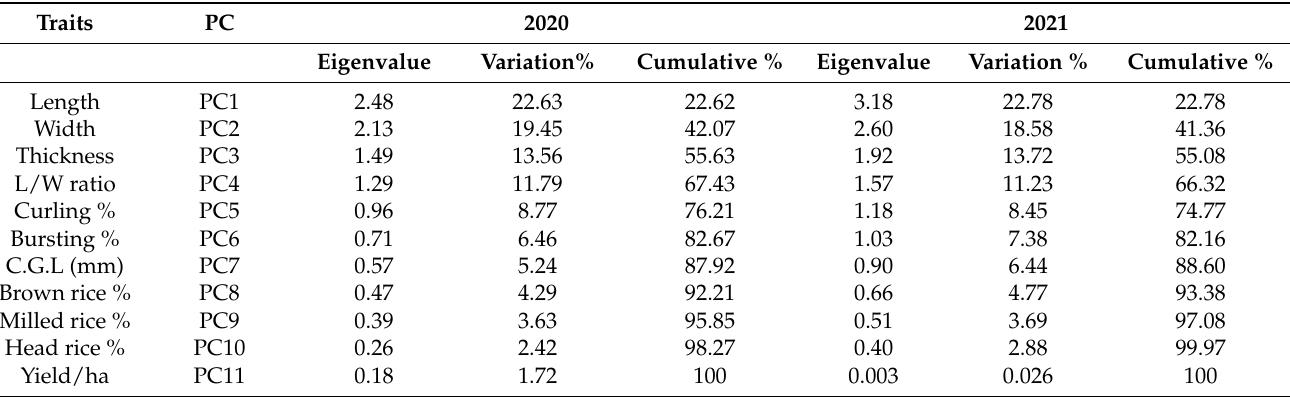
Table 4. Eigenvalue, variation and cumulative% variability of various yield and quality parameters of hybrid